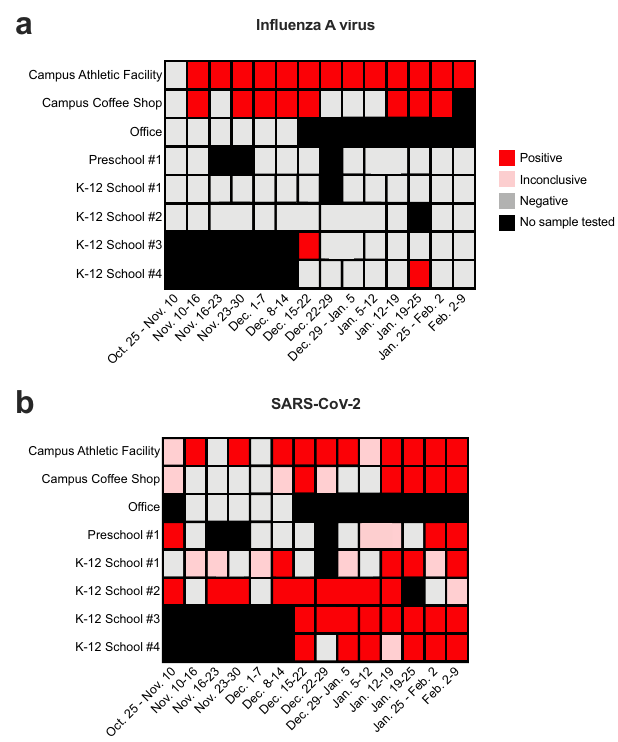
Fig. 4 | Detection of SARS-CoV-2 and In fl uenza A virus in Dane County, WI. a In fl uenza A virus (IAV) detection in air samples collected from congregate set- tings. IAV genomic material was detected by semi-quantitative RT-PCR using the TrueMark Respiratory 2.0 TaqMan Array Card. b SARS-CoV-2 detection in air samples collected from congregate settings. SARS-CoV-2 genomic material was detected by two separate RT-qPCR N1 and N2 CDC assays. Boxes shaded in red, pink, and gray represent positive, inconclusive, and negative air samples collected duringthesamplingintervalinthex-axis.Nosamplewastestedforboxesshadedin black. Campus sites were located on the college campus of the University of